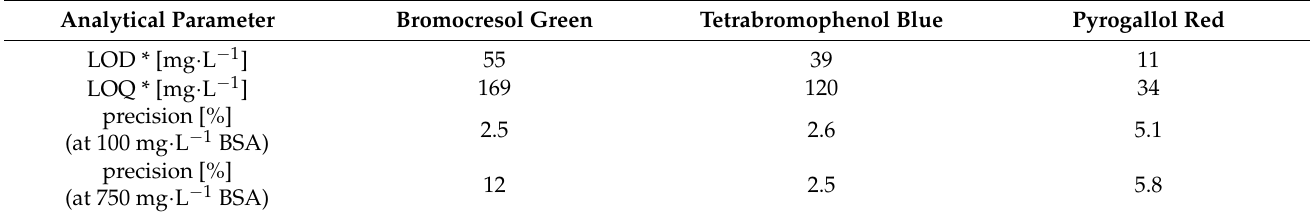
Table 3. Analytical parameter comparison for paper-based sensors operating according to the previously optimized assays.